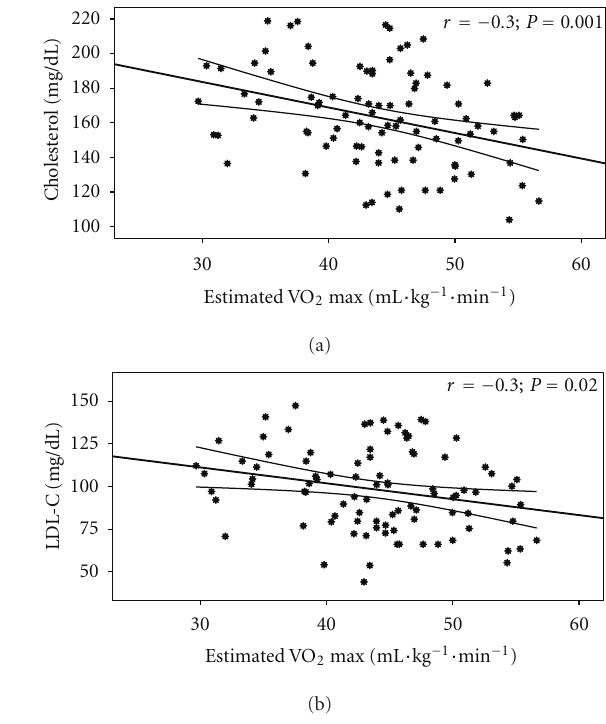
Figure 3: Estimated VO 2 relationship with MAP in the females (a) ( r = − 0 . 2; P = 0 . 005) and males (b) ( r = − 0 . 2; P = 0 . 04).